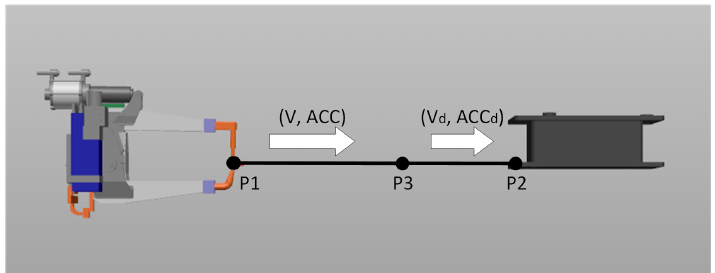
Figure 10. Robot approach to process point. P1—start point, P2—process point, P3—additional point, V-linear speed of the robot, ACC-acceleration coefficient, V d -modified linear speed of the robot, ACC d -modified acceleration